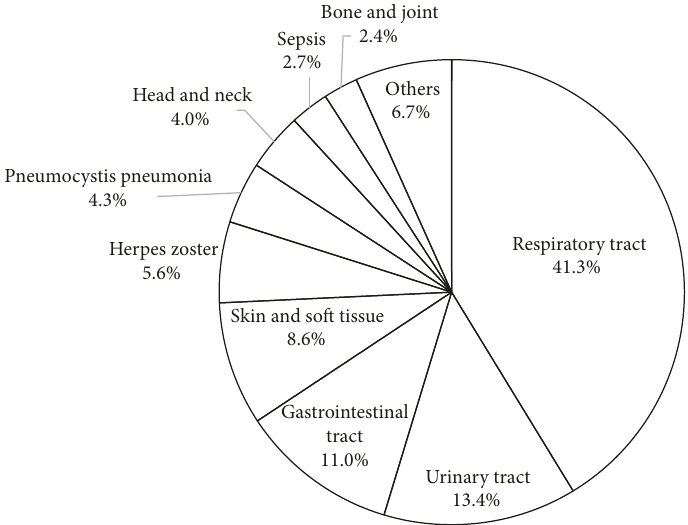
Figure 1: Sites and types of infections. Gastrointestinal tract includes biliary